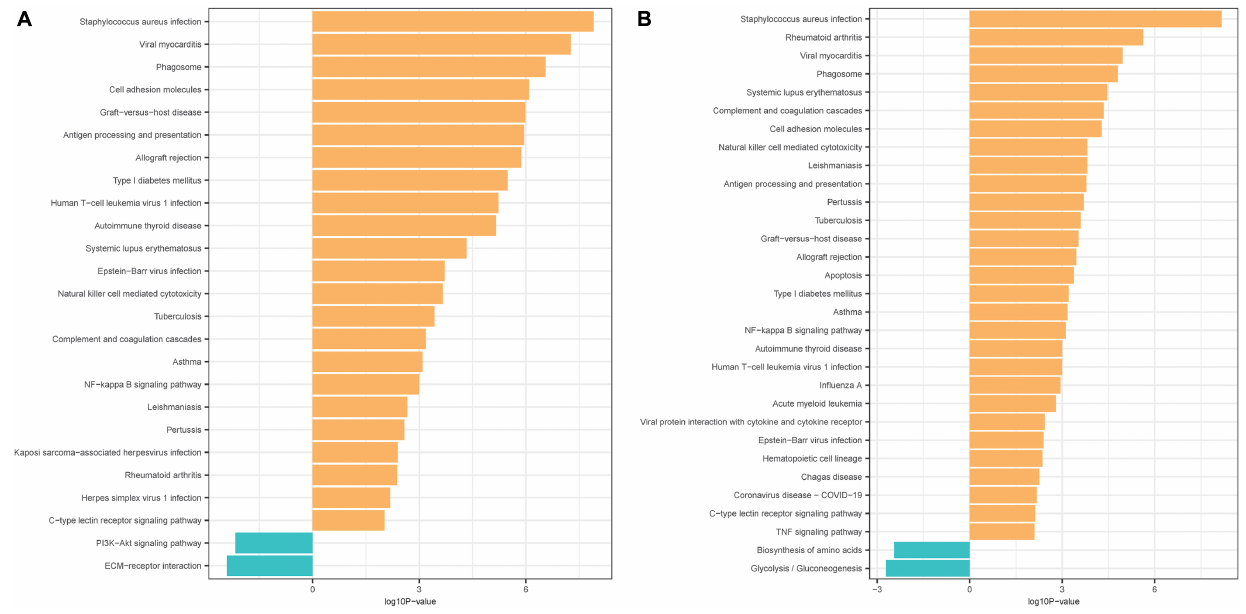
Frontiers in Medicine |